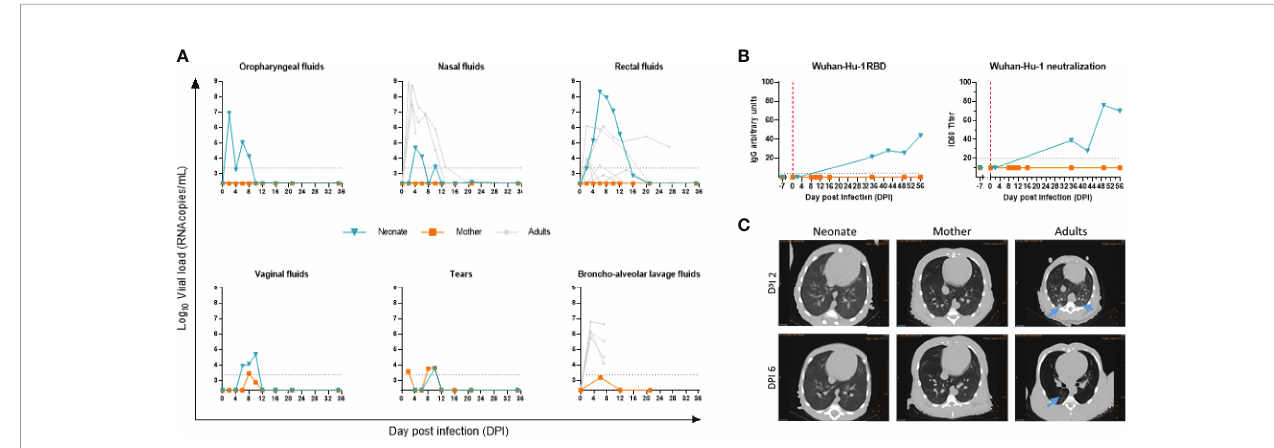
FIGURE 2 | Follow-up of SARS-CoV-2 infection. (A) Viral RNA load measured by RT-qPCR in the oropharyngeal, nasal, rectal, vaginal, tears, and bronchoalveolar fl uidic compartments. The blue line is for the neonate, orange line for the mother, and gray lines for adult NHPs. The limit of detection was estimated at 2.37 log10 copies/ml, and the limit of quanti fi cation was estimated at 3.37 log10 copies/ml (dotted horizontal line). (B) Line plots of RBD IgG arbitrary units (AU) and 50% inhibitory serum dilution (ID50) against SARS-CoV-2 Wuhan-Hu-1 in sequential serum samples of the neonate. (C) Thoracic CT scan at DPI 2 (upper panel) and DPI 6 (lower panel) for neonate (left), mother (middle), and infected adult (right). Blue arrows point to ground-glass